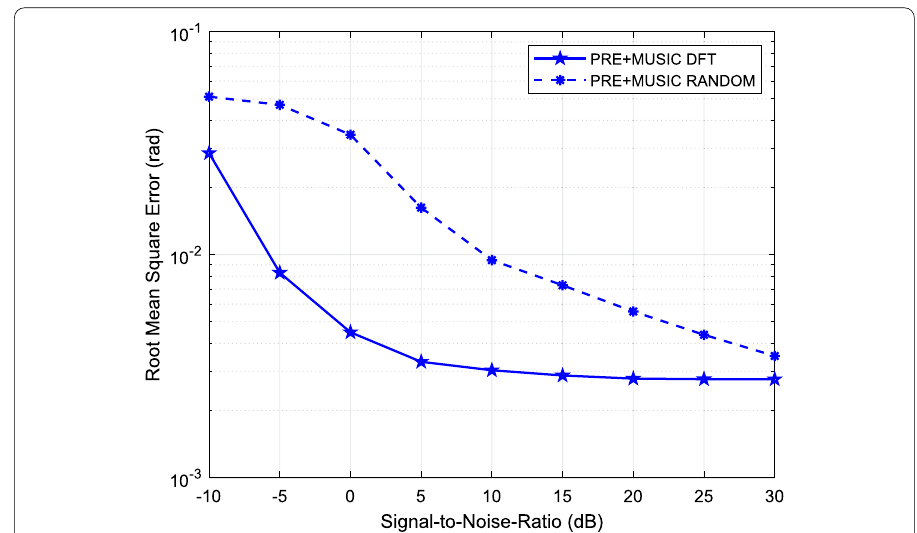
Fig. 9 RMSE of AoA estimation of PREMUSIC for a combiner matrix based on (i) DFT and (ii) random phase shifters, M c = 500 , S 1 = 20 , S 2 = 80 , (cid:31) =